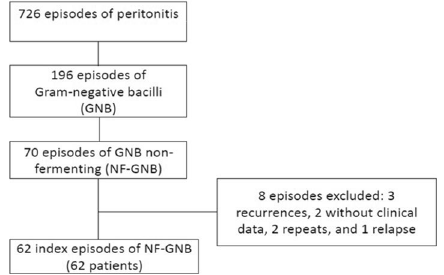
Figure 1. Flow diagram showing from the total peritoneal-related bacterial peritonitis episodes to index episodes caused by nonfermenting gram-negative